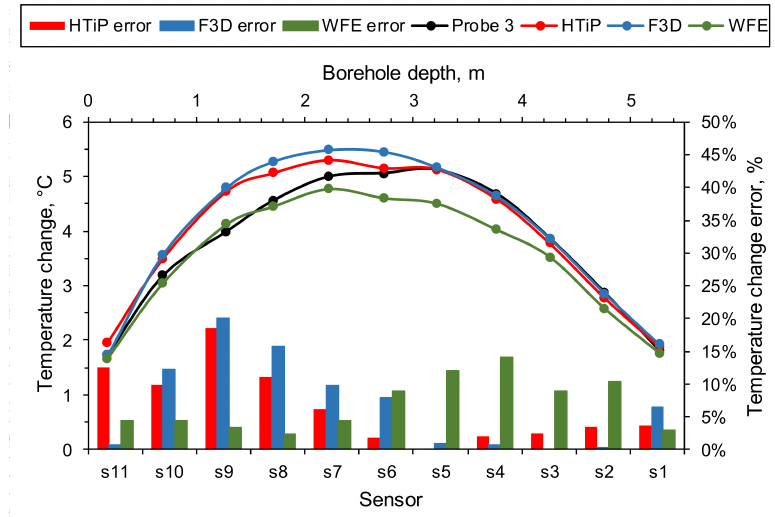
Figure 10. Measured and simulated changes in rock temperature after the 21-day heating phase at sensor locations (s1–s11) along the monitoring borehole depth for the HTiP, F3D, and WFE modelling approaches. Additionally, bars with errors in simulated temperature change are plotted for each modelling